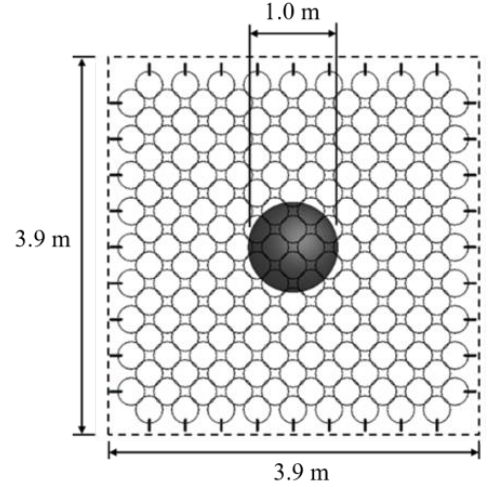
Figure 20. The ratio of loading head area to ring net area. Figure 21 indicates the equivalent coefficient curves of different ratios of loading